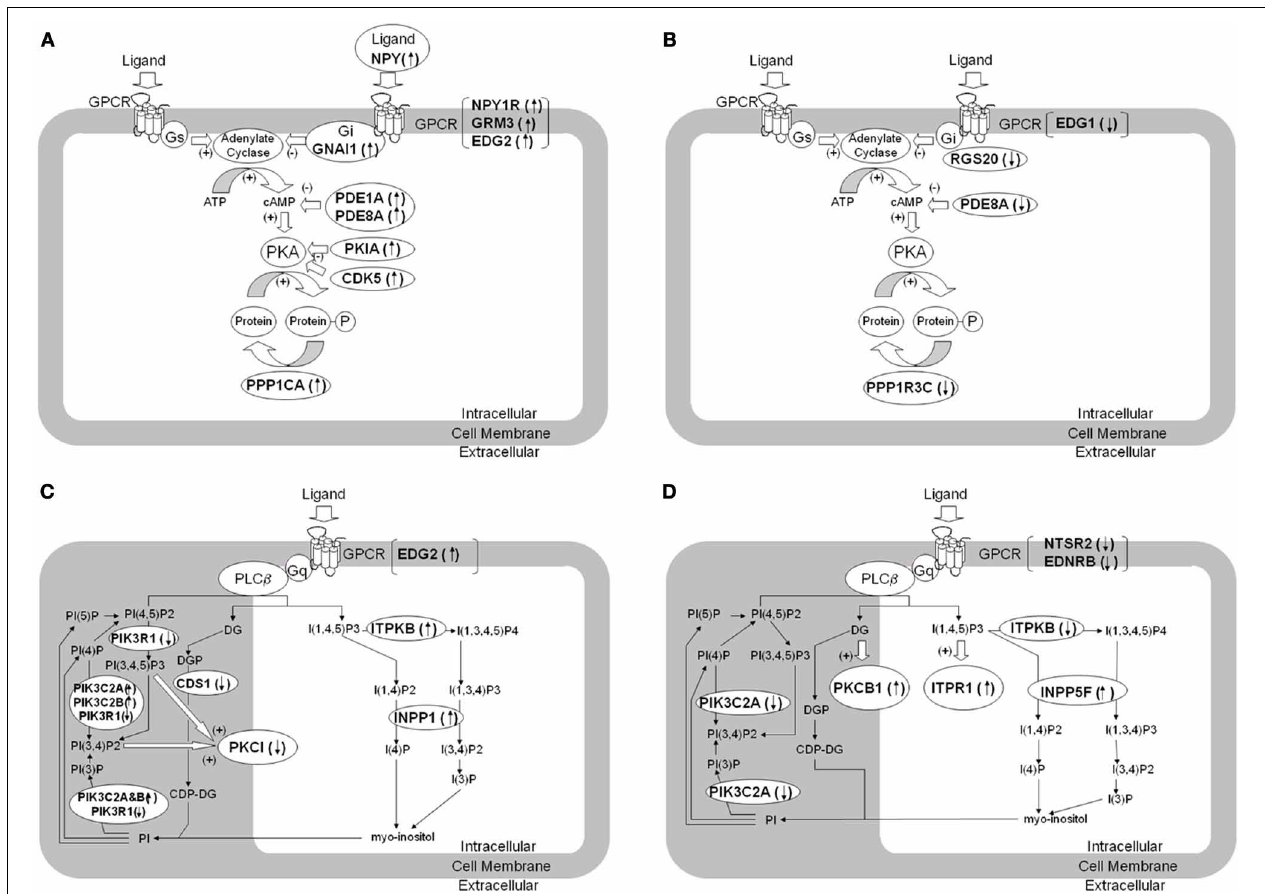
FIGURE 1 | Dysregulation of genes involved in cAMP- and phosphatidylinositol signaling pathways in brain tissue from patients with BPD and MDD. The figure summarizes differentially expressed genes regulating signaling pathways using second messengers of cAMP (A,B) and phosphatidylinositol (C,D) in brain tissue from BPD (A,C) and MDD (B,D) compared to control subjects. The differentially expressed genes are denoted in italic and bold. (A) shows increased expression of transcripts related to suppression of cAMP mediated signaling in BPD. (B) shows decreased expression of transcripts related to suppression of cAMP mediated signaling in MDD. (C) shows altered expression of transcripts related to phosphatidylinositol mediated signaling in BPD. (D) shows altered expression of transcripts related to phosphatidylinositol mediated signaling in MDD. GNAI1, G protein alpha inhibiting activity 1; RGS20, Regulator of G-protein